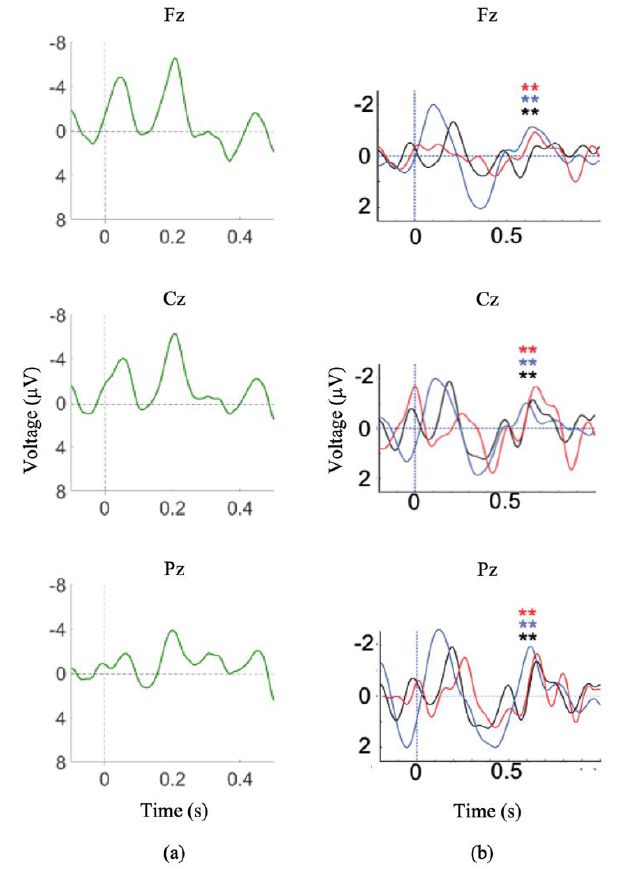
Figure 4. Module 3 ERP responses I. ( a ) Averaged waveforms for common first names stimuli, N1 and P2 waveforms are present. ( b ) Difference waves for incongruent/congruent stimuli (SVS paradigm) during Session 1(black), Session 2 (red), and Session 4 (blue). ** indicates significant difference between congruent and incongruent waveforms ( p < 0.05). Note: a 7 Hz smoothing filter was applied for visualization only.